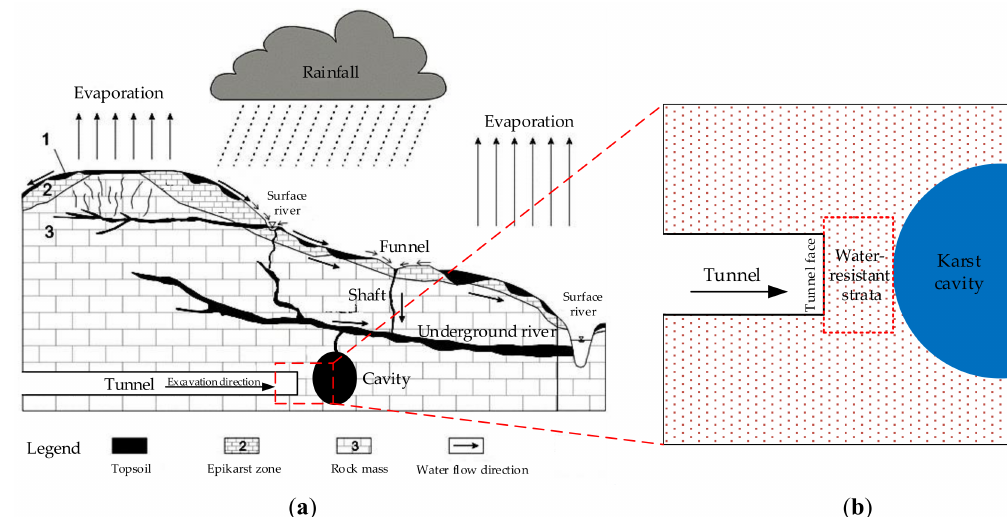
Figure 1. Research area of karst tunnel water-resistant strata stability in karst strata. ( a ) Conceptual model of karst geomorphological strata; ( b ) Conceptual model for stability study of water-resistant strata of karst